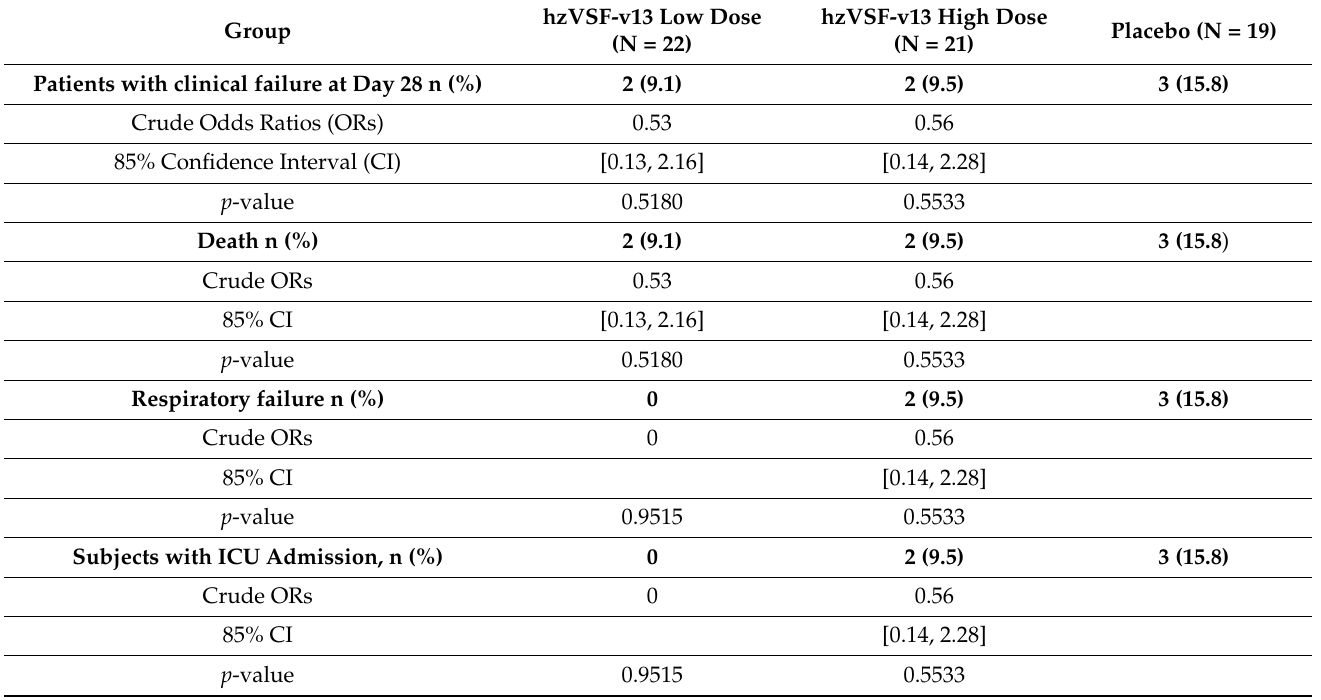
Table 2. Primary outcome as composite endpoint and by event at Day 28, as well as logistic regression analysis. Full analysis set